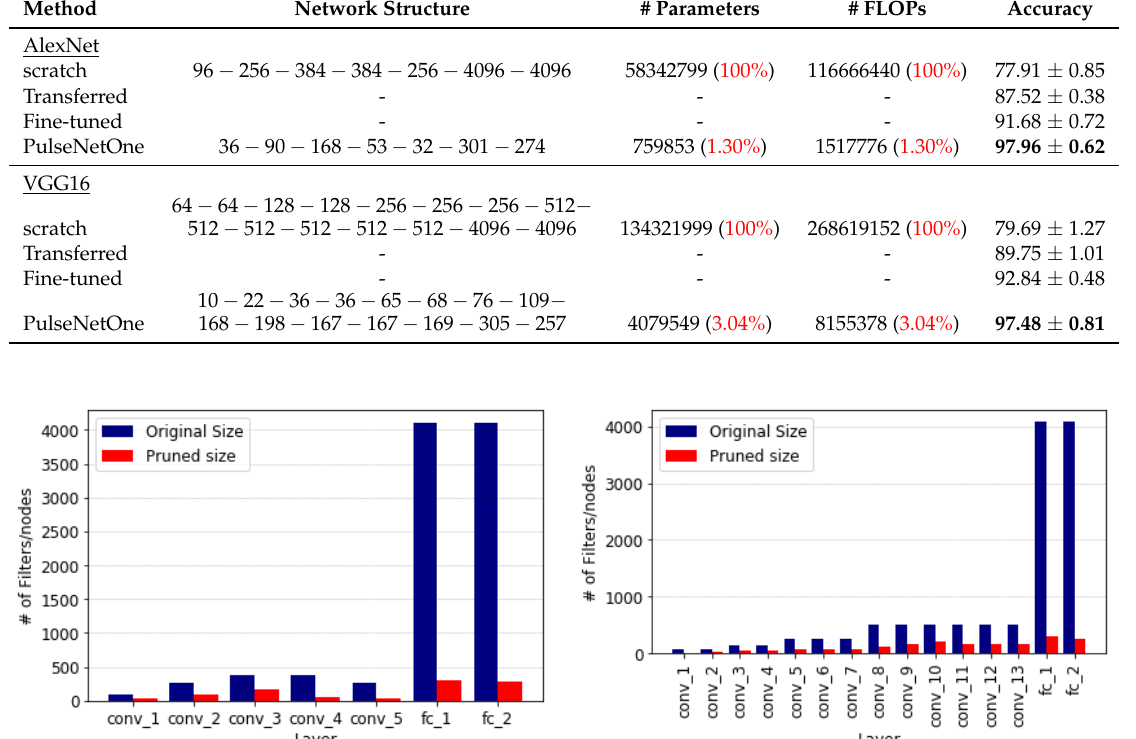
Table 8. Overall accuracies and standard deviations (%) of different CNNs methods along with the proposed PulseNetOne on the Scene15 dataset. The entries in bold show the method with the best classification for the network, while the percentage of the original network is highlighted in red.